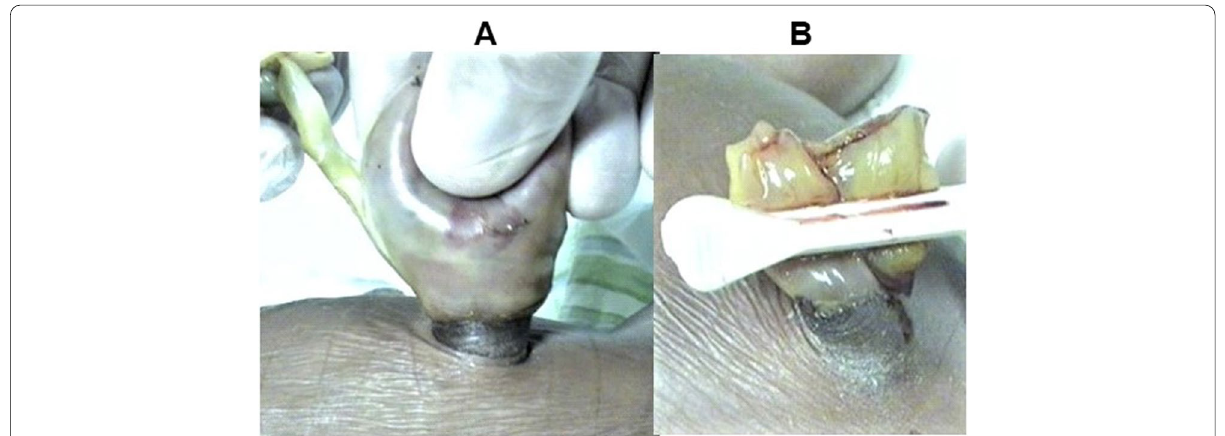
Fig. 1 Usual hernia of umbilical cord ( A ) that was easy to reduce the content. Treated with simple manual reduction of the contents and closure of the sac with application of proximal umbilical clamp ( B )